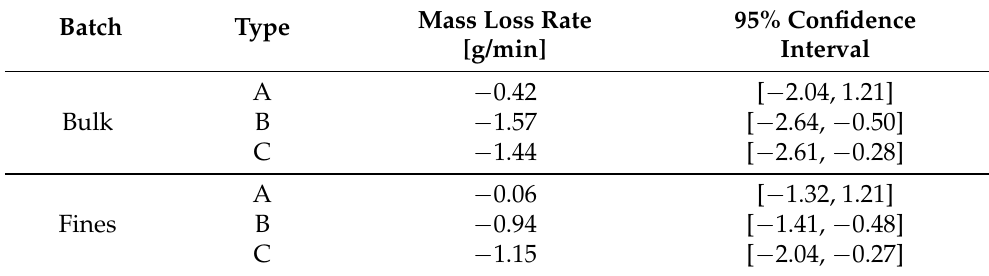
Table 4. Mass loss rates and 95% Confidence interval for the different alumina types.